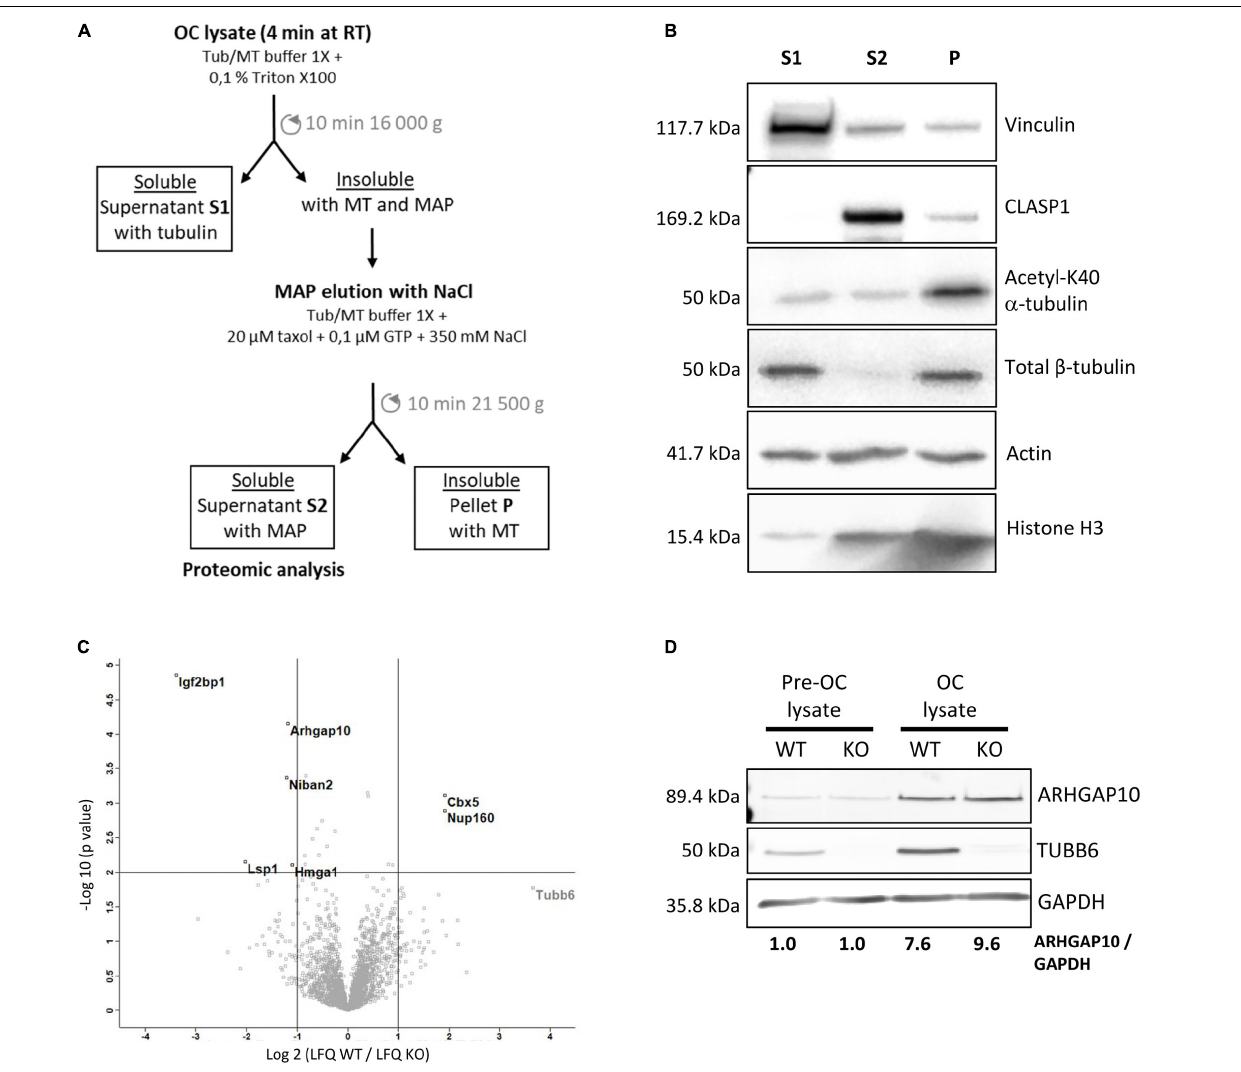
FIGURE 5 | Characterization of the microtubule-associated protein fraction of WT and Tubb6 KO osteoclasts. (A) Schematic representation of the osteoclast fractionation strategy in microtubule-stabilizing Tub/MT buffer to obtain soluble proteins (S1), a fraction enriched in microtubule-binding protein (S2) and an insoluble fraction containing microtubules (P). (B) Representative immunoblot analysis of selected protein distribution between the different fractions: Vinculin, CLASP1, acetylated K40 α -tubulin, β -tubulin, actin, and Histone H3. (C) Volcano plot of Label Free Quantitation (LFQ) results from four independent mass spectrometry experiments, showing proteins that are significantly more abundant in S2 from KO (top left) and WT (top right) osteoclast, with vertical lines indicating twofold change cut off and horizontal line p = 0.01 cut off, with x axis in log 2 (LFQ WT/LFQ KO) and y axis in –log 10 ( p -value). (D) Representative immunoblot analysis of ARHGAP10, TUBB6 and GAPDH expressions in WT or Tubb6 KO RAW264.7 cells (Pre-OC) and in the osteoclasts (OC) derived from these